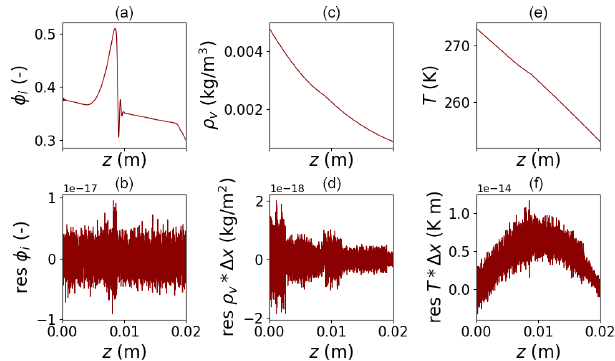
Figure B1. Results upon lowering the residuals of all equations. While some pattern is still visible, the order of magnitude is small enough to assume small errors in the solution as